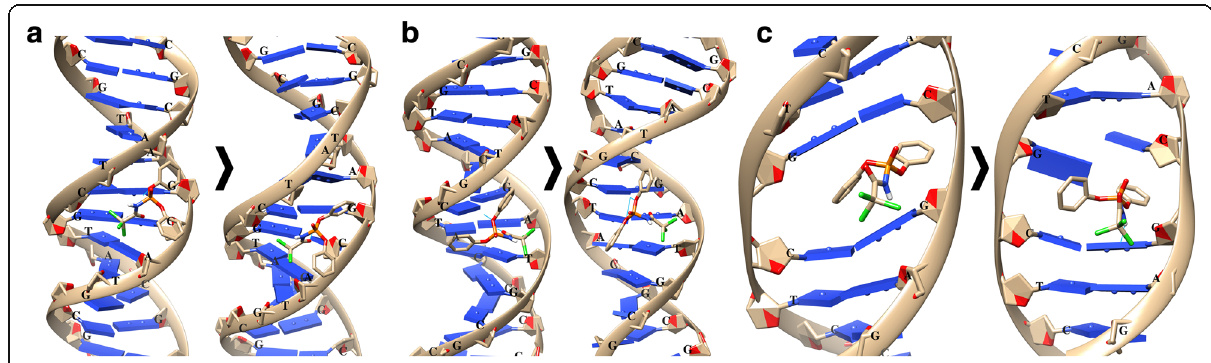
Fig. 3 Interaction of diphenyl-N-(trichloroacetyl)-amidophosphate (HL) with DNA molecule: a , b binding with minor and major grooves; c intercalation into a minor groove. The used DNA structure from PDB database: a , b — 2M2C and c —